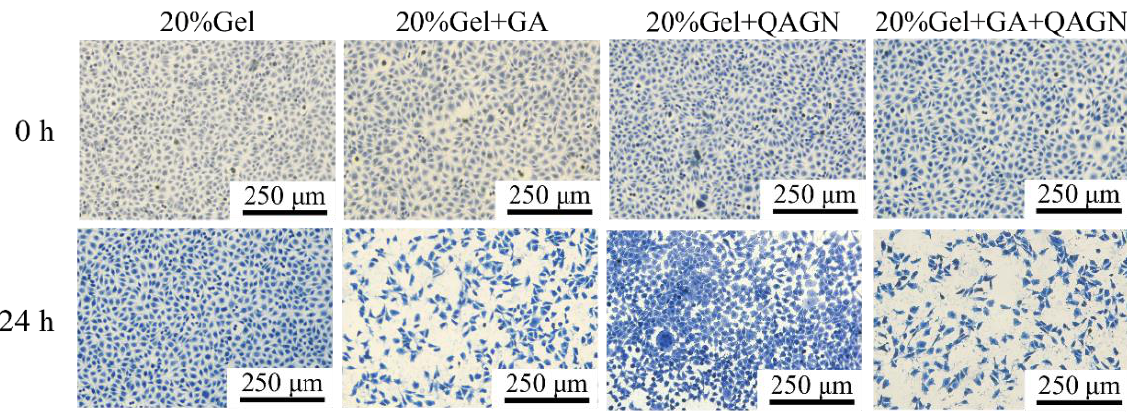
Figure 8. Collagen content staining with various loaded MN patches for 24 h.